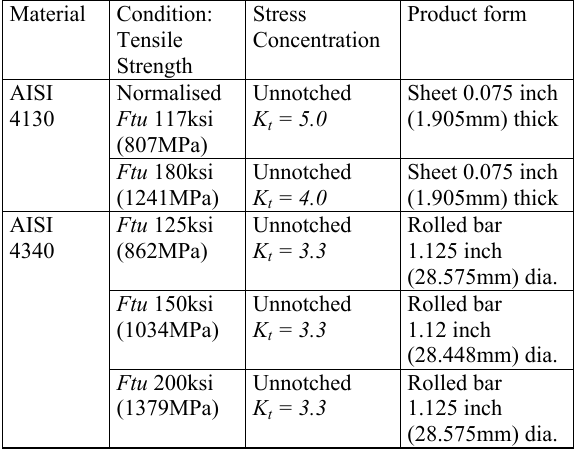
Table 2. Materials considered in the